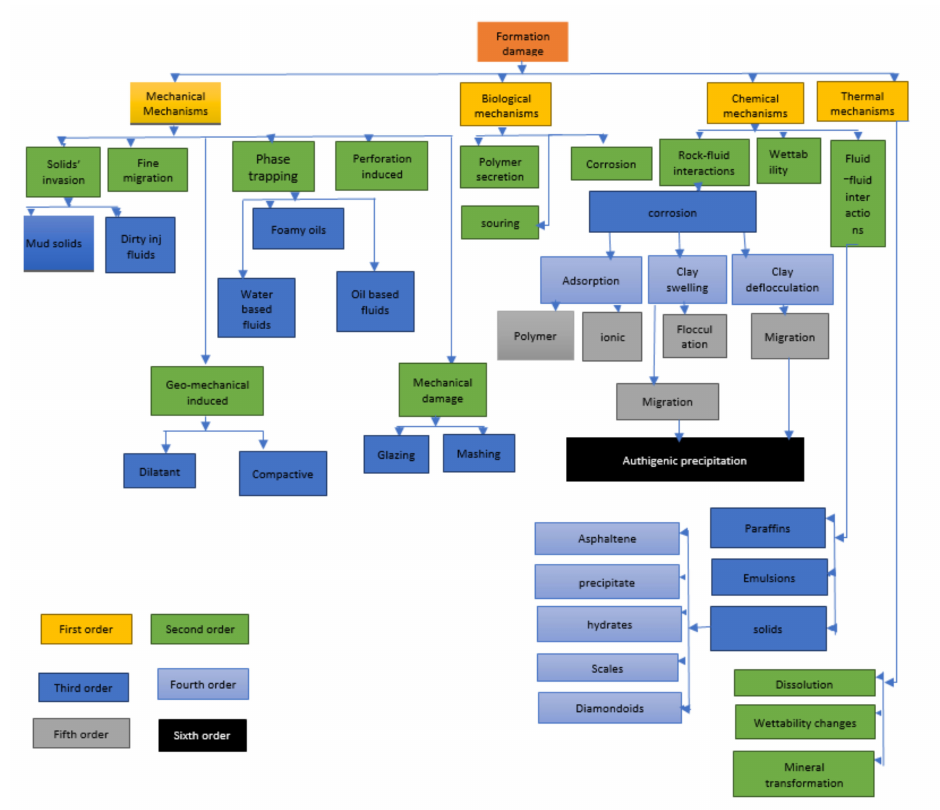
Figure 6. Category of formation damage mechanisms in sandstone, modified from [6].